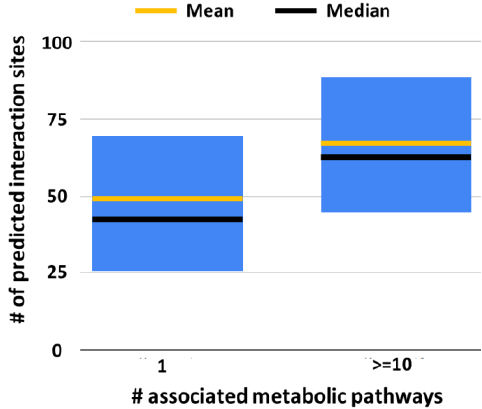
Figure 4. Statistical characterization of the number of interaction sites predicted with ISPRED4 in EC proteins associated with only one or at least 10 metabolic pathways. For each set, the boxes represent the first and third quartiles; yellow and black lines represent mean and median values, respectively. Significance of the reported difference on median values has been validated using the Mann–Whitney U test obtaining p -value = 0.04. # Number of.